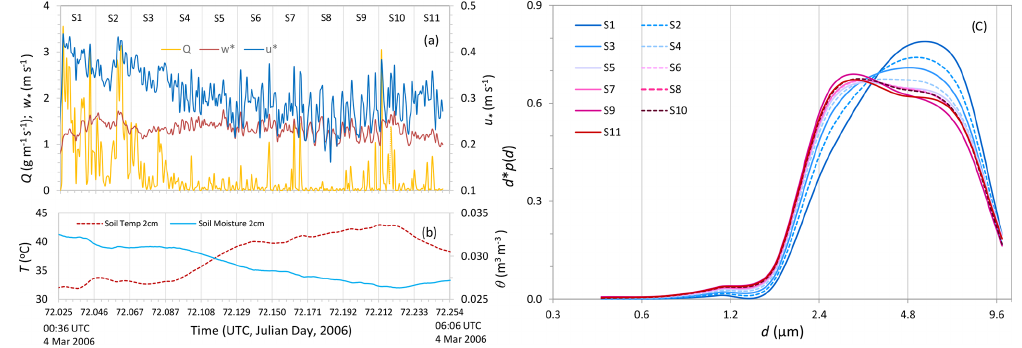
Figure 10. (a) Time series of streamwise saltation flux, Q (gm − 1 s − 1 ); convective scaling velocity, w ∗ (ms − 1 ); and friction velocity, u ∗ (ms − 1 ), for Event-12. The time span of Event-12 is divided into 11 half-hourly sections, labelled as S1, S2, etc. (b) Same as (a) but for soil temperature, T ( ◦ C), and soil moisture, θ (m 3 m − 3 ), both at 0.02m depth. (c) Dust PSDs averaged over Sects. S1, S2,